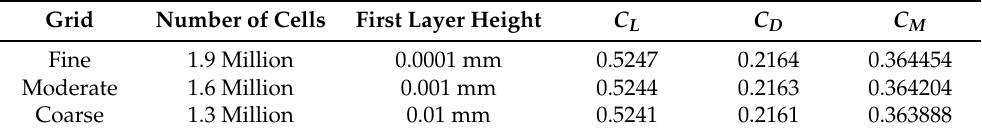
Table 4. Grid Specifications and Results.